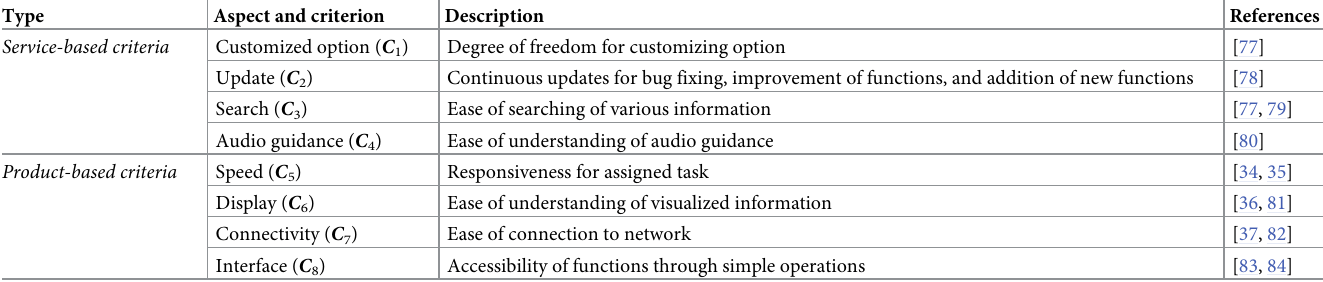
Table 4. Criteria for mobile service evaluation within navigation